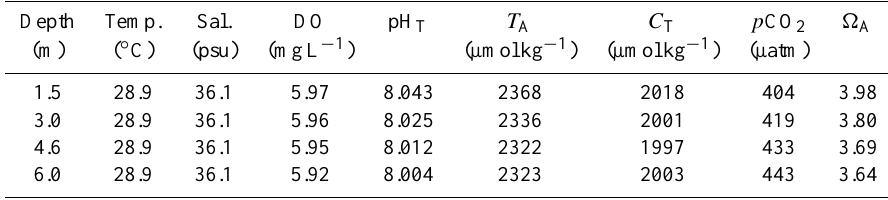
Table 4. Vertical profile data.